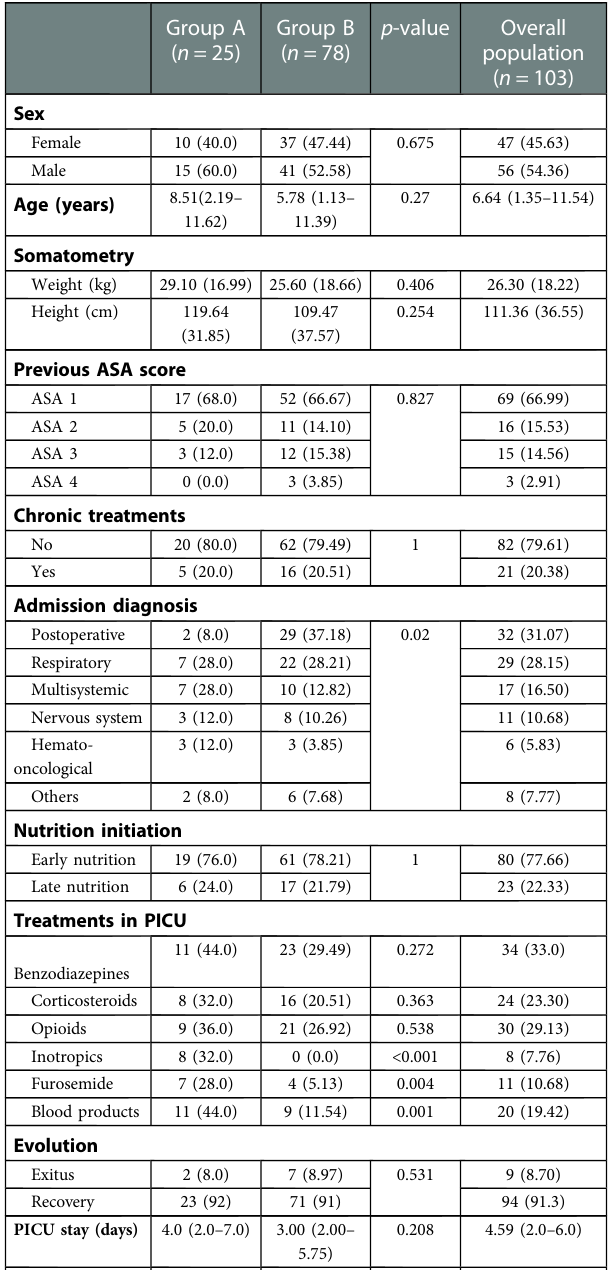
TABLE 1 Demographic and clinical data.